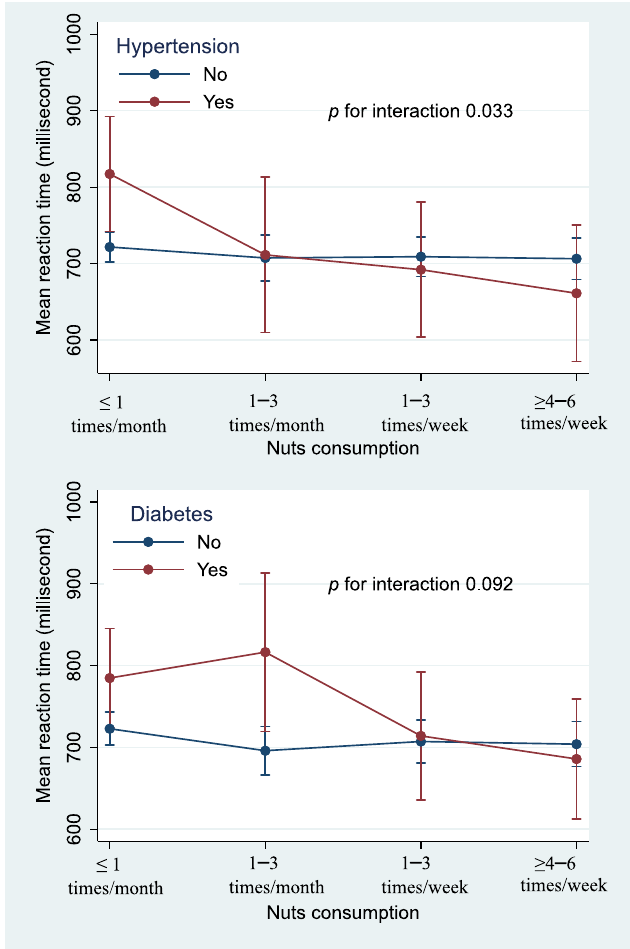
Figure 2. Interaction between nuts consumption and hypertension and diabetes in relation to cog- nitive function. Models were adjusted for age, sex, education, and literacy levels, smoking, physical activity level, and BMI.